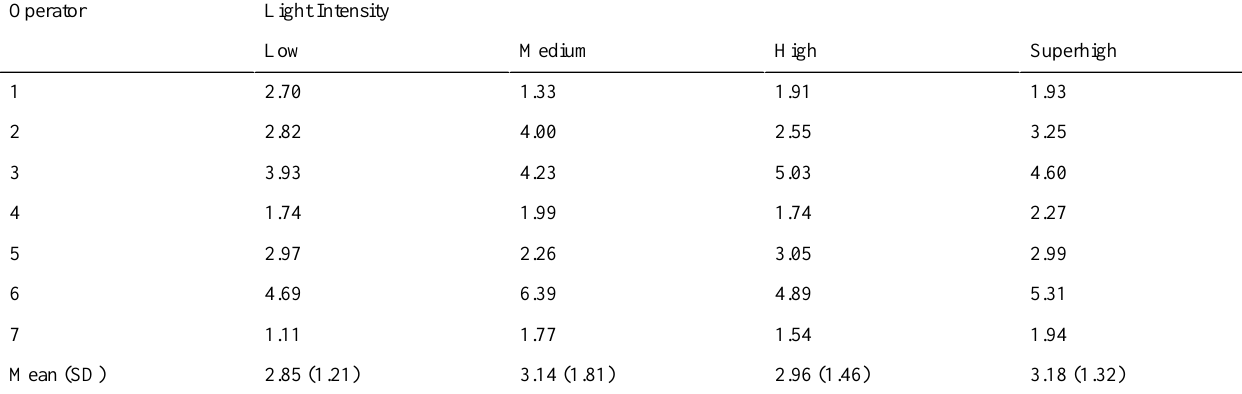
Table 3. Static error under different light intensities (mm).